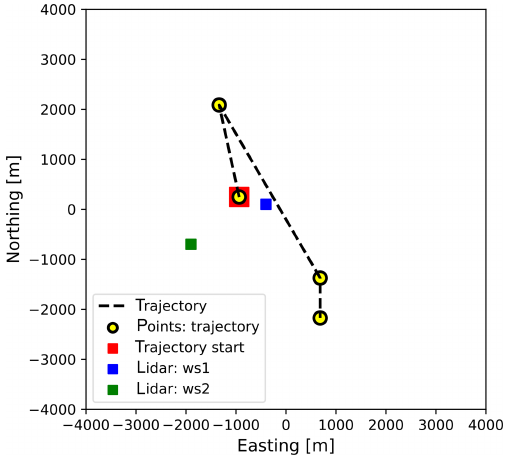
Figure 17. Final campaign layout for Turkish